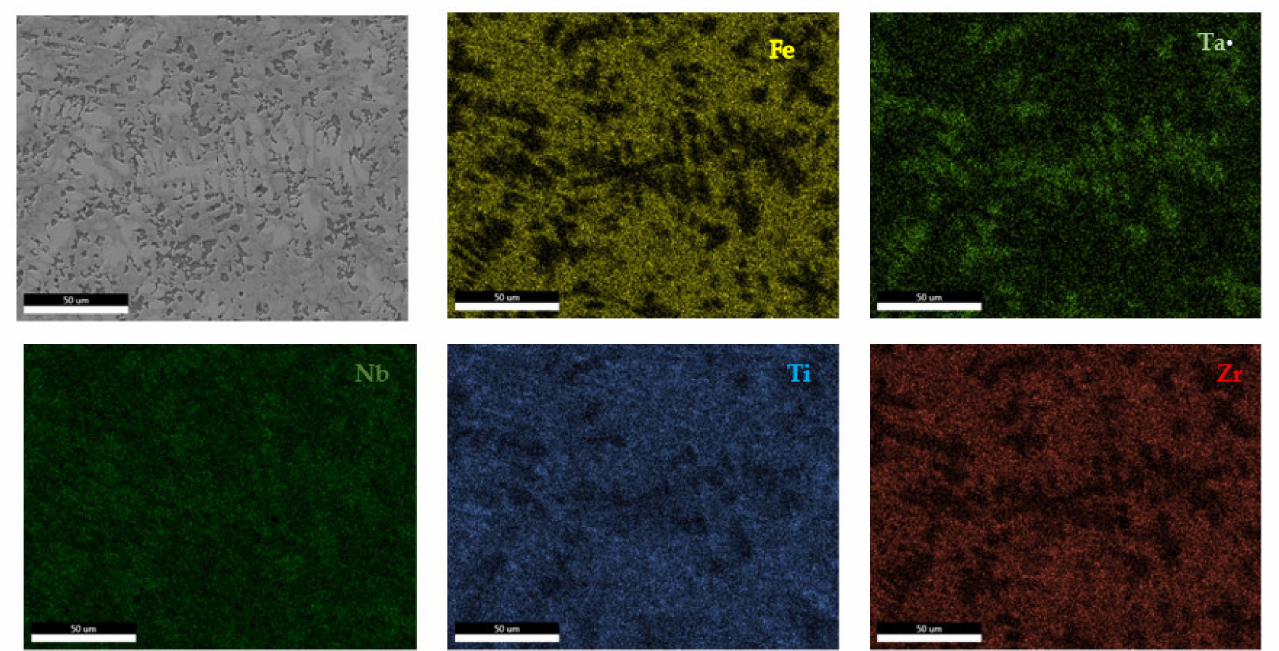
Figure 12. EDS mapping of the remelted FeTa 0.5 Nb 0.5 Ti 1.5 Zr 0.5 alloy.